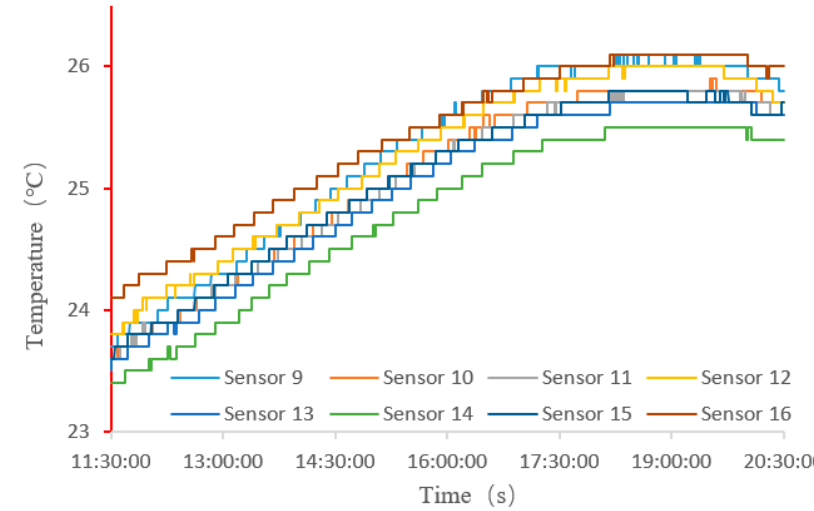
Figure 7. The temperature changes at the measurement locations on the right column.